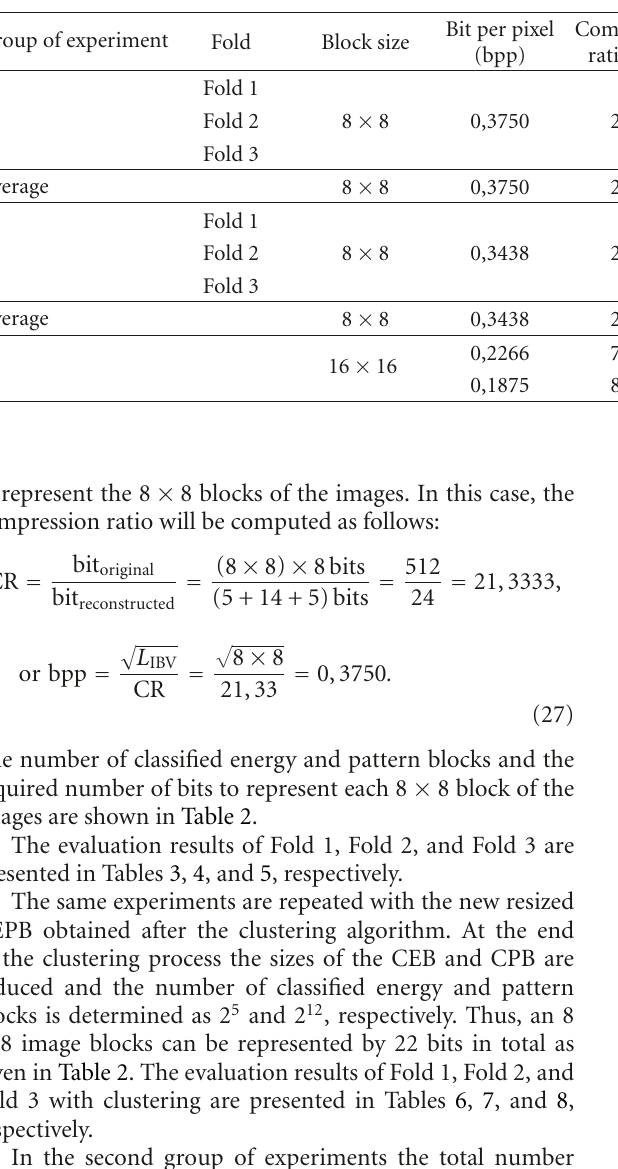
Table 12: Evaluation results